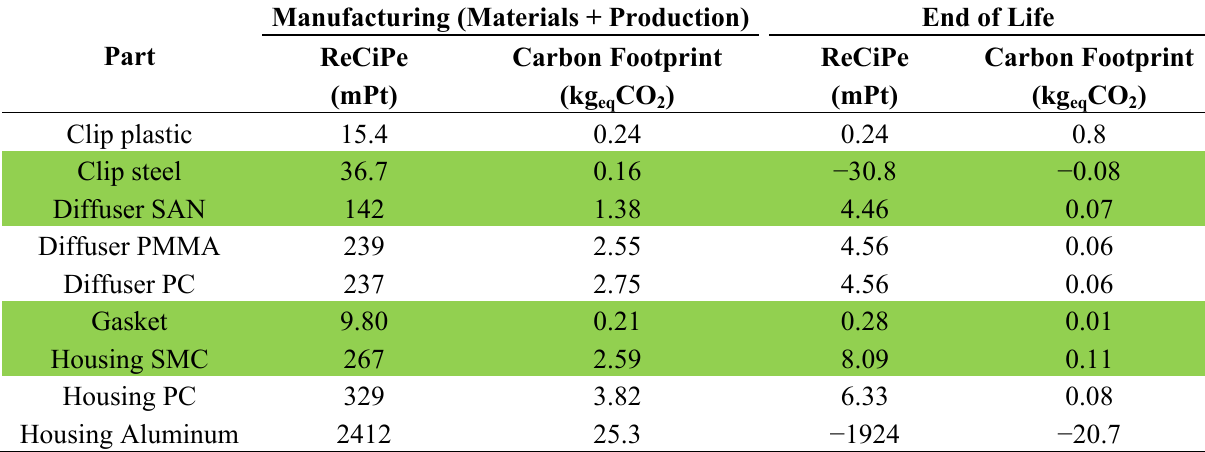
Table 8. Results for Scenario